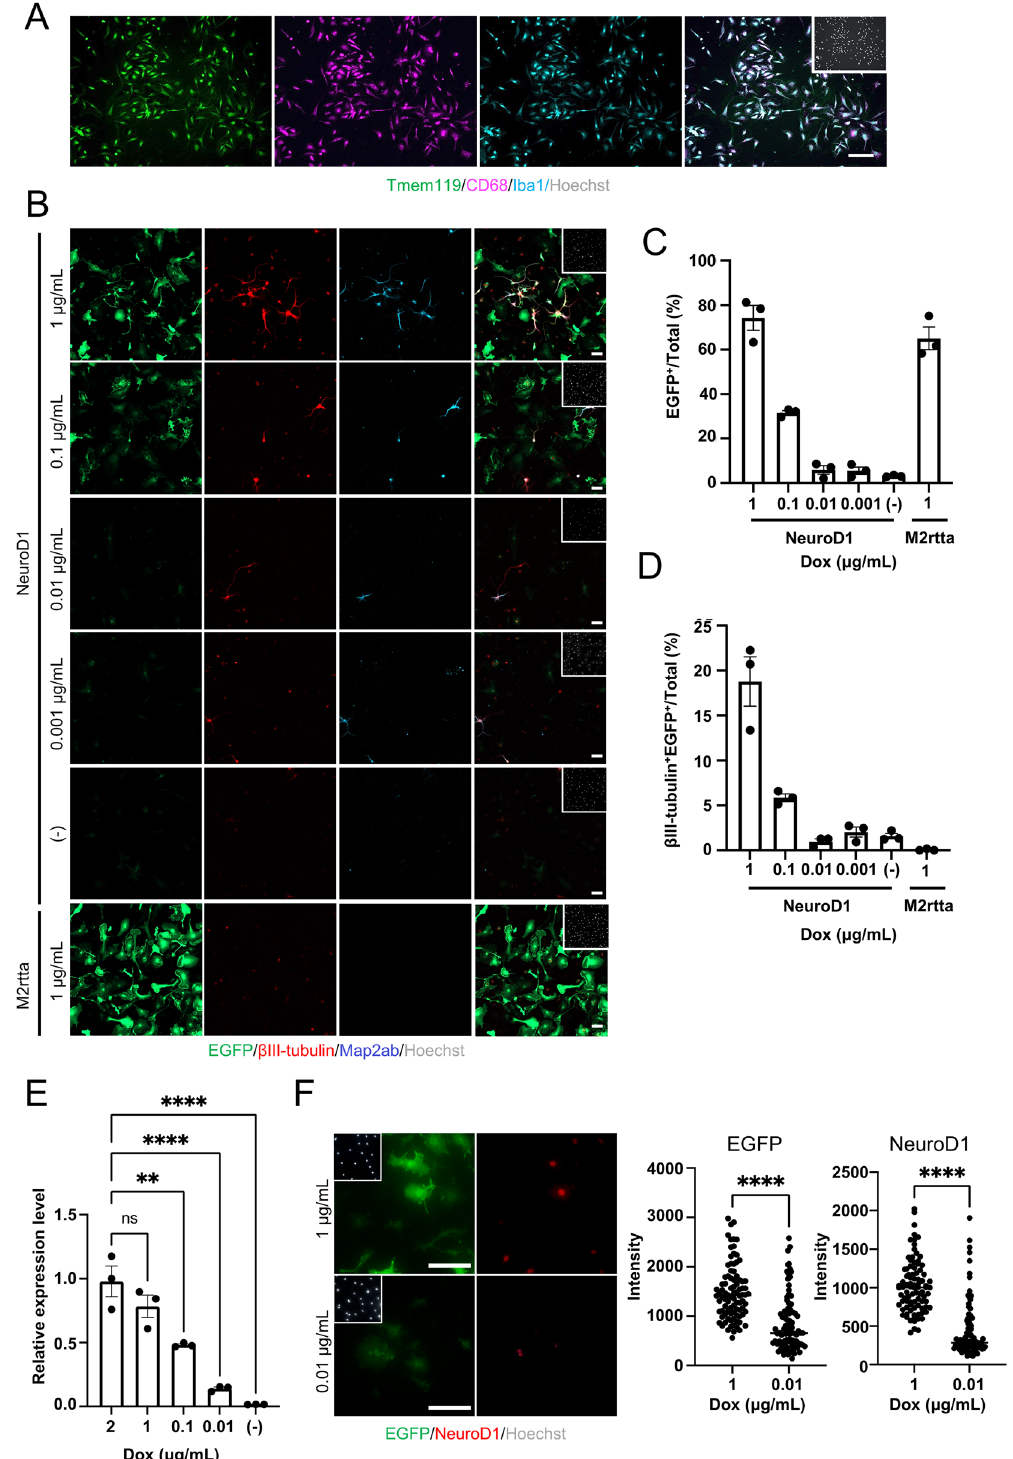
Figure 1. Surpassing an RF expression threshold is required to convert microglia efficiently into neurons ( A ) Representative images of staining for microglial markers Tmem119 (green), CD68 (magenta), and Iba1 (cyan) in primary isolated microglia. Scale bar, 75 μm. ( B ) Representative images of staining for EGFP (green), and the neuronal markers βIII-tubulin (red) and Map2ab (cyan), at 7 days post-transduction (dpt) of microglia infected with three viruses (EGFP-, M2rtta-, and NeuroD1-viruses; indicated as NeuroD1) or two viruses (EGFP- and M2rtta-viruses; indicated as M2rtta) under the indicated Dox concentration treatment conditions. Scale bars, 50 μm. ( C ) Quantification of the EGFP + cells in ( B ) (n = 3). ( D ) Quantification of the βIII-tubulin + EGFP + cells in ( B ) (n = 3). ( E ) qRT-PCR analysis of total NeuroD1 mRNA levels in NeuroD1-transduced microglia at 2 dpt under the indicated Dox concentration treatment conditions (n = 3 biological replicates). ** p < 0.005, *** p < 0.0005, **** p < 0.0001 by ANOVA with Tukey post hoc tests. ns means not significant ( p > 0.05). ( F ) Representative images of staining for EGFP (green) and NeuroD1 (red) in NeuroD1-transduced microglia at 2 dpt under 1 or 0.01 μg/mL Dox induction (left). Intensity of EGFP or NeuroD1 in left panel (right). **** p < 0.0001 by unpaired Student’s t test. ns means not significant ( p > 0.05). Scale bars, 75